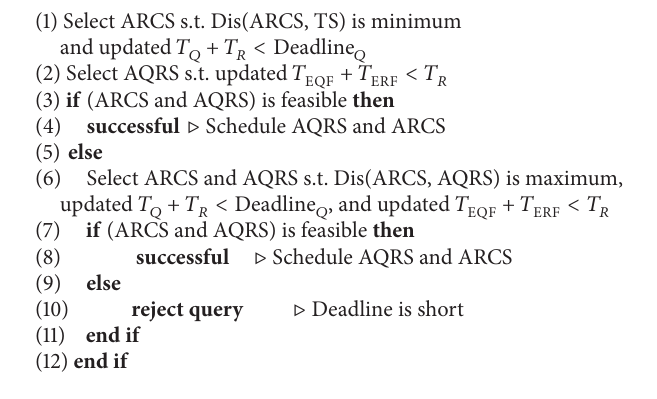
Algorithm 3: Calculate Maximum Energy Consuming